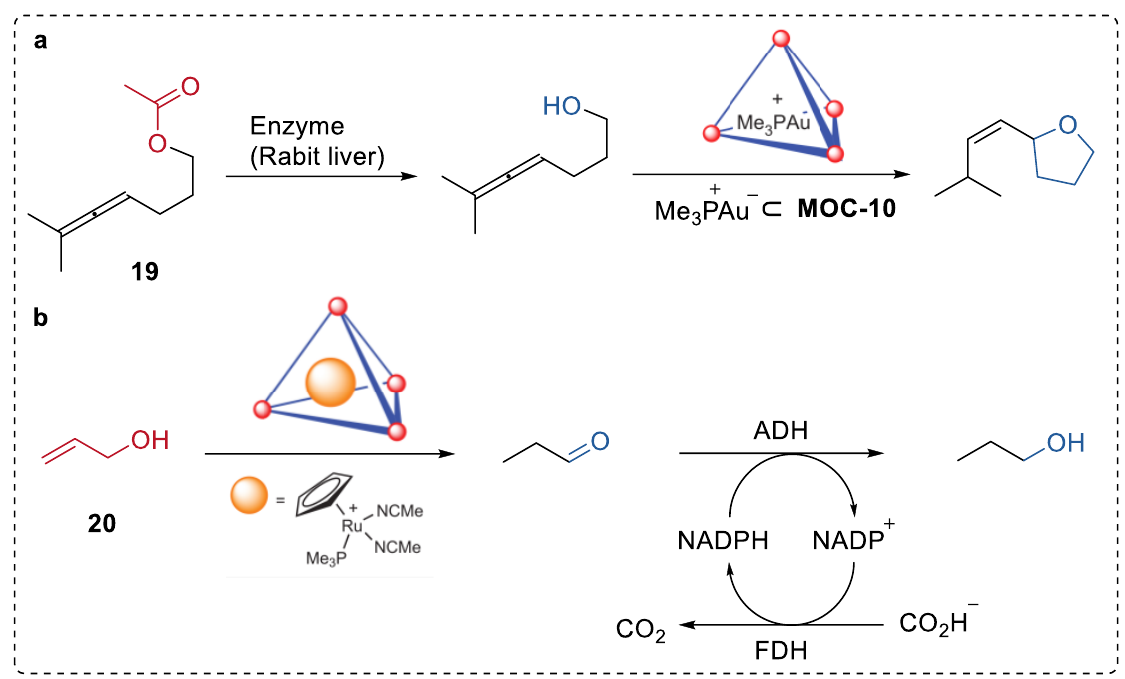
Figure 15. ( a ) Hydrolysis – cyclization tandem reactions of allenic acetate catalyzed by spatially separated natural enzyme (rabit liver) and Me 3 P + Au _ encapsulated in MOC-10 [82]. Reaction additions: 19 (1.2 × 10 − 2 mmol), MOC-10 (10 mol%), Me 3 P + Au − (10 mol%), enzyme (Rabit liver, 6 unit), MeOH/DMSO (0.5 mL), pH = 8, 37 °C. ( b ) Isomerization of 1-propenol the sequential reduction of propanal catalysed by spatially separated (Me 3 P)CpRu(NCMe) 2+ encapsulated in MOC-10 and al- cohol dehydrogenase (ADH). Reprinted/adapted with permission from Ref. [82]. Copyright 2013 Springer Nature Ltd.